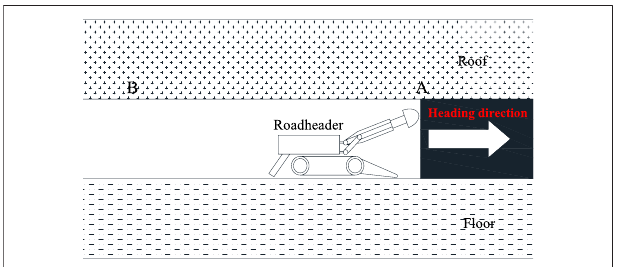
FIGURE 6 | Schematic diagram of the driving